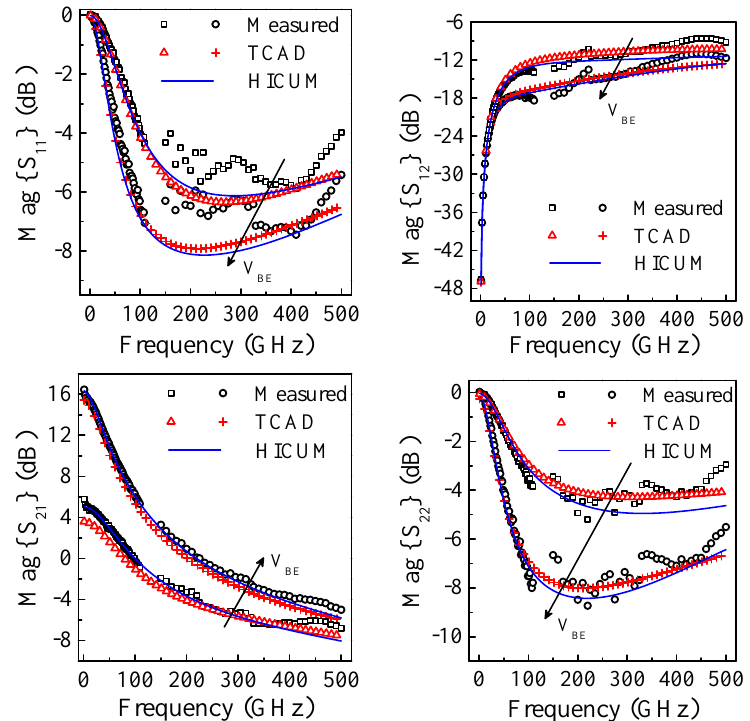
Figure 18. Frequency dependent magnitude of scattering parameters for the 0.09 µ m × 4.8 µ m SiGe HBT biased at V BC = 0 V with V BE = 0.8 V and 0.85 V: comparison between measured data (rectangles and circles), TCAD (triangle and cross) and HICUM (solid